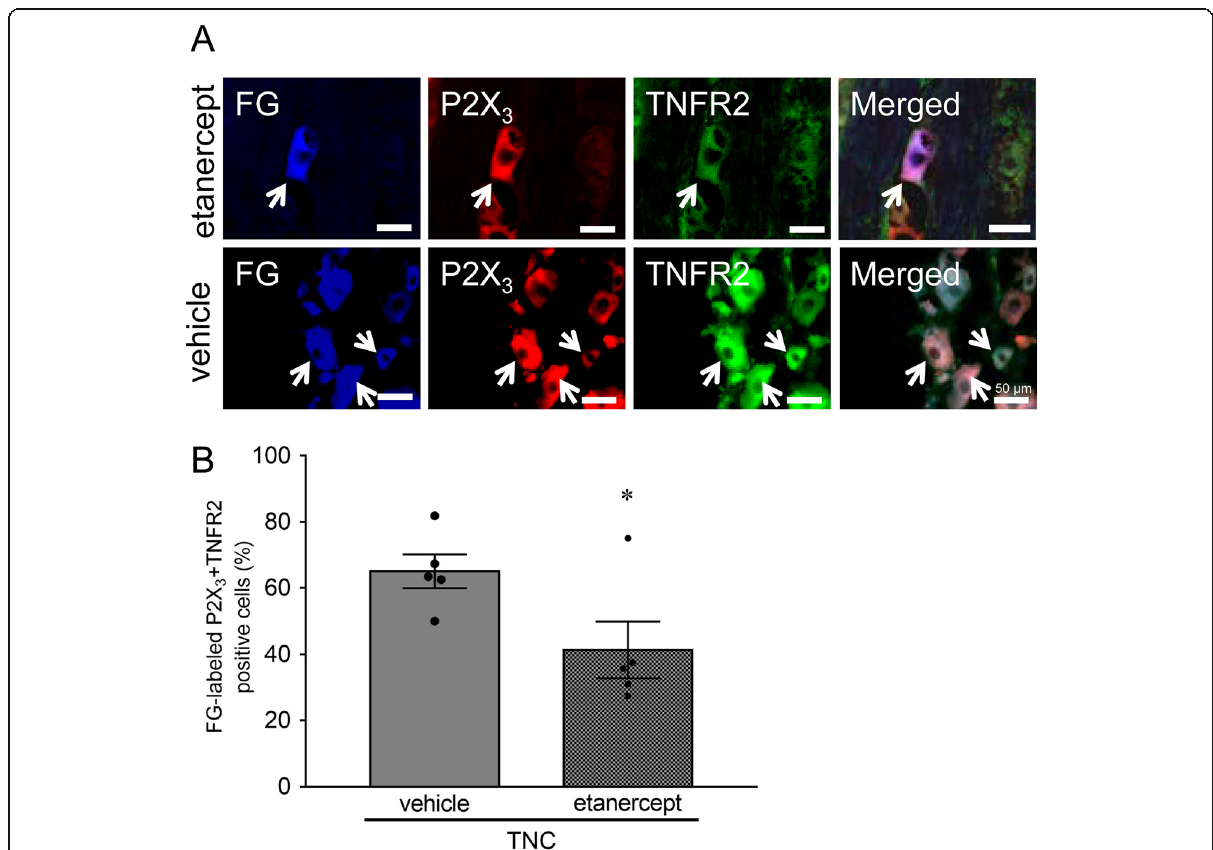
Fig. 5 Involvement of TNFR2 signaling in the enhanced P2X 3 R expression in TG neurons on day 7 following TNC. a Photomicrograph of FG- labeled P2X 3 -IR and TNFR2-IR TG neurons following TNC with intra-TG etanercept or vehicle administration. Arrows indicate FG-labeled P2X 3 -IR and TNFR2-IR TG neurons. Scale bar: 100 μ m. b Changes in the mean percentage of FG-labeled P2X 3 -IR and TNFR2-IR TG neurons on day 7 following TNC with intra-TG etanercept or vehicle administration. * p < 0.05 vs. vehicle. ( n = 6 in each, student ’ s t